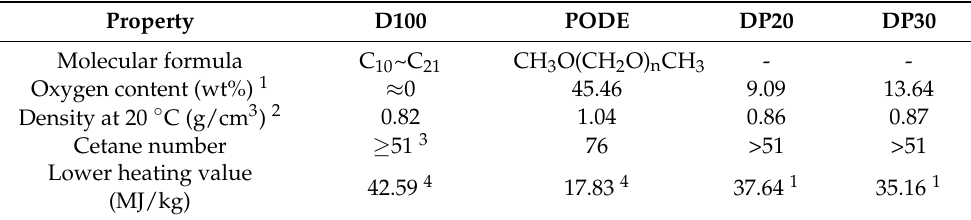
Table 1. Some of physical and chemical properties of the diesel and PODE used in tests. Property